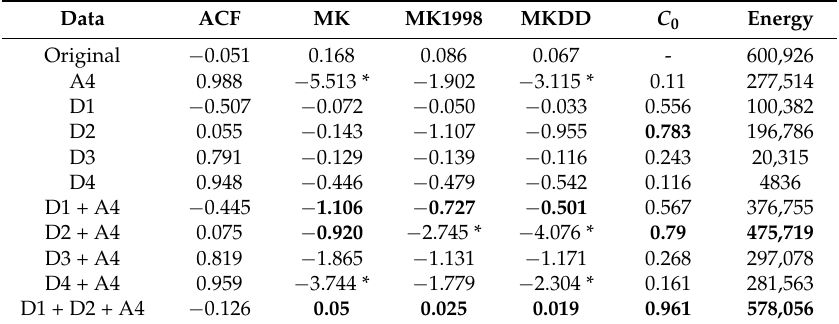
Table 7. Lag-one ACFs, Mann-Kendall values and energy of seasonal total precipitation series: original data, details components (D1–D4), approximations (A4) and a set of combinations of the details and their respective approximations. C 0 is the correlation coefficients between the decomposition combinations and the original series.